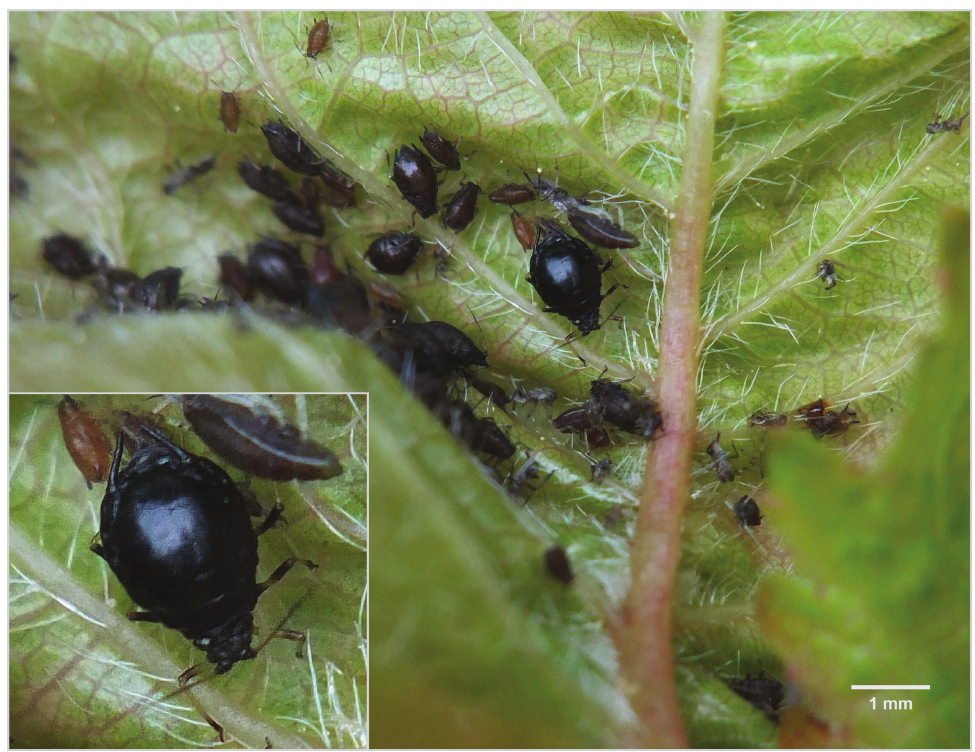
Fig. 30. Myzus cerasi (Fabricius, 1775). Apt. and juv. on Prunus